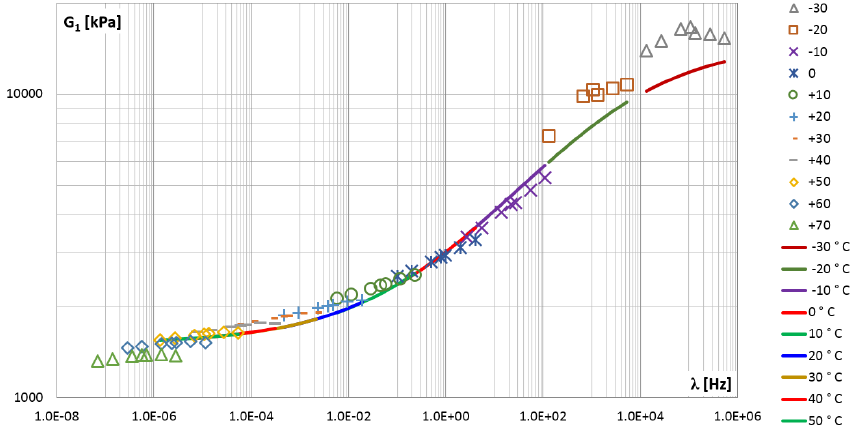
Figure 18. The shear storage modulus G 1 vs. frequency-master